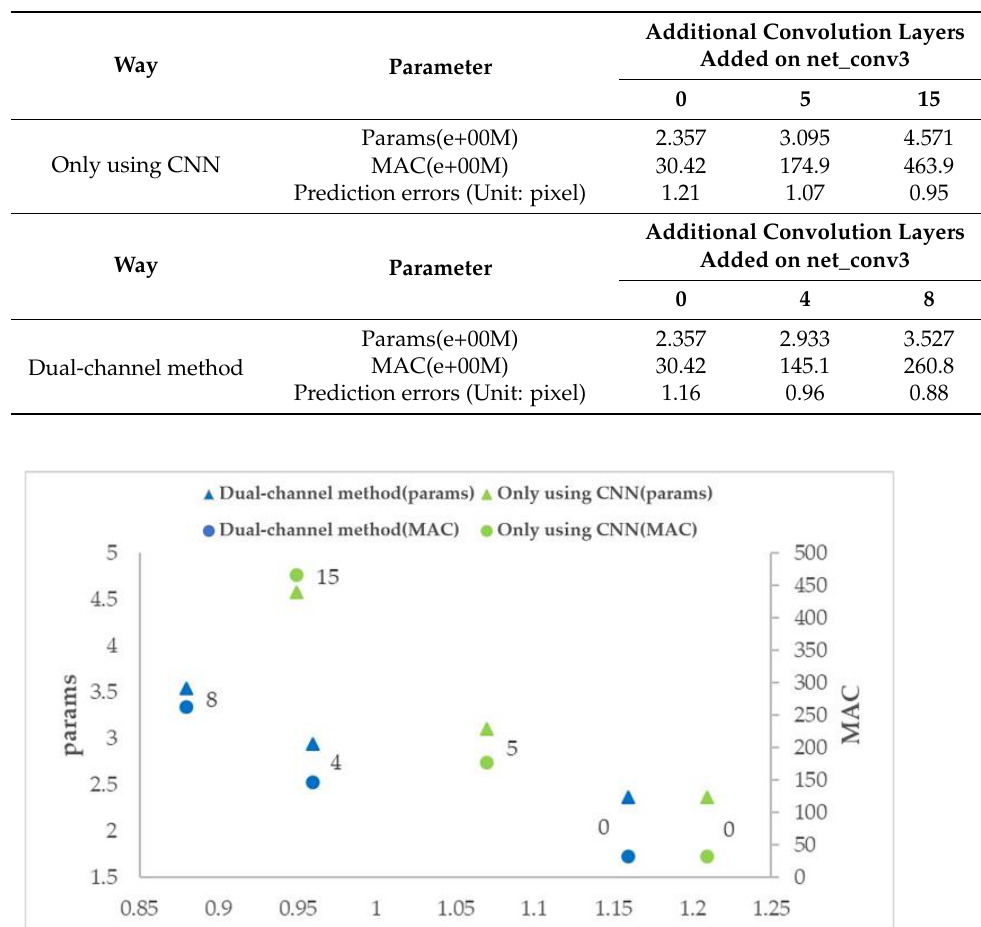
Figure 19. Average prediction loss of five parameters with random seed 1. Table 4. Prediction error and computational efficiency of different networks.